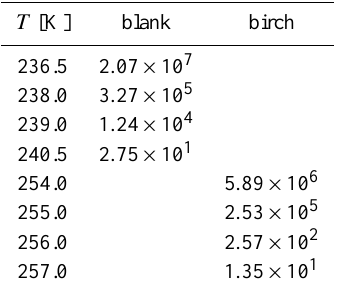
Table 3. Listing of nucleation rates J [cm − 3 s − 1 ] at given temper- atures for pure water droplets and droplets containing birch pollen. The results are plotted in Fig.